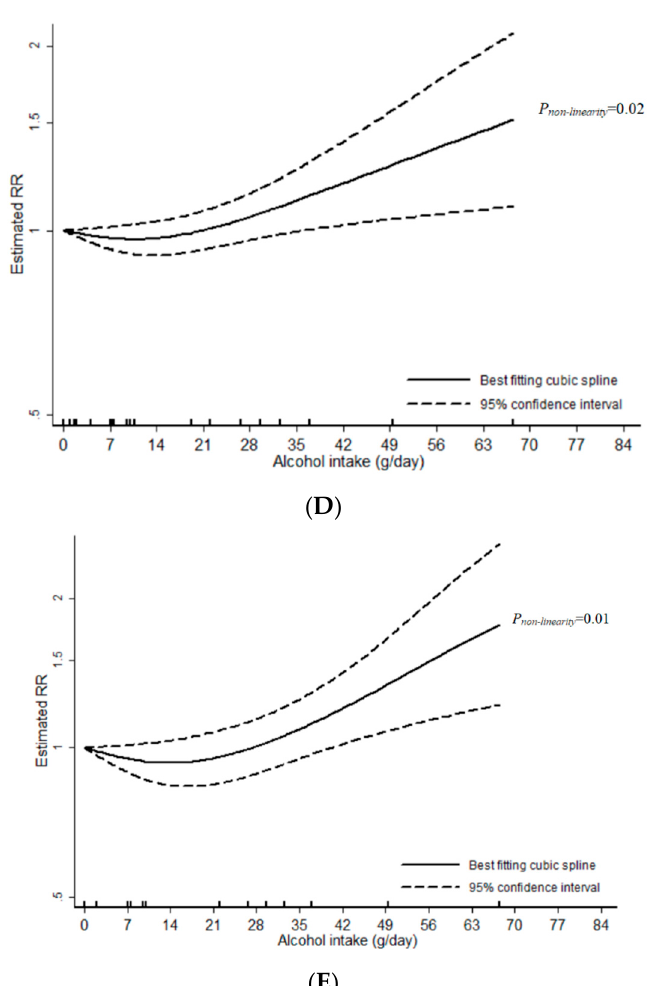
Figure 3. Meta-analyses of wine intake and prostate cancer risk: ( A ) linear analysis with non-aggressive PCa; ( B ) non-linear analysis with non-aggressive PCa; ( C ) linear analysis with aggressive PCa; ( D ) non-linear analysis with aggressive PCa; ( E ) non-linear analysis with aggressive PCa (Sensitivity). Abbreviations: PCa, prostate cancer; RR, relative risk; CI, confidence interval.